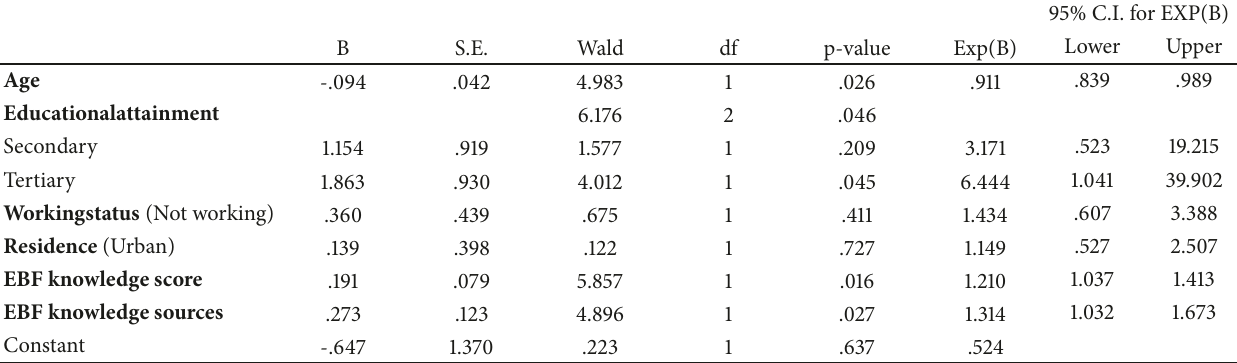
Table 6: Logistic regression model coefficients on intention of exclusive